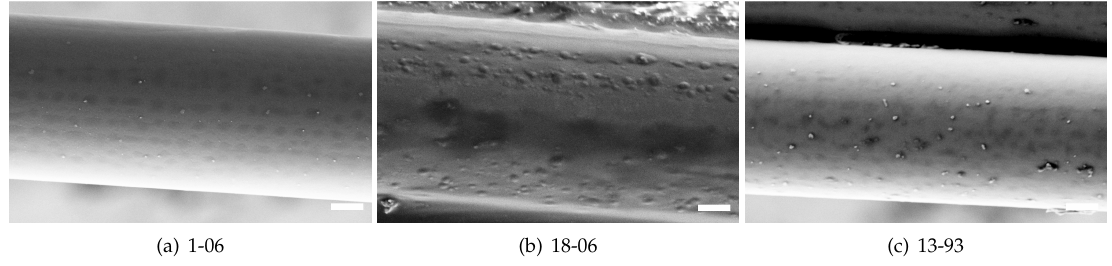
Figure 9. SEM images of the unreacted fibres (scale bars